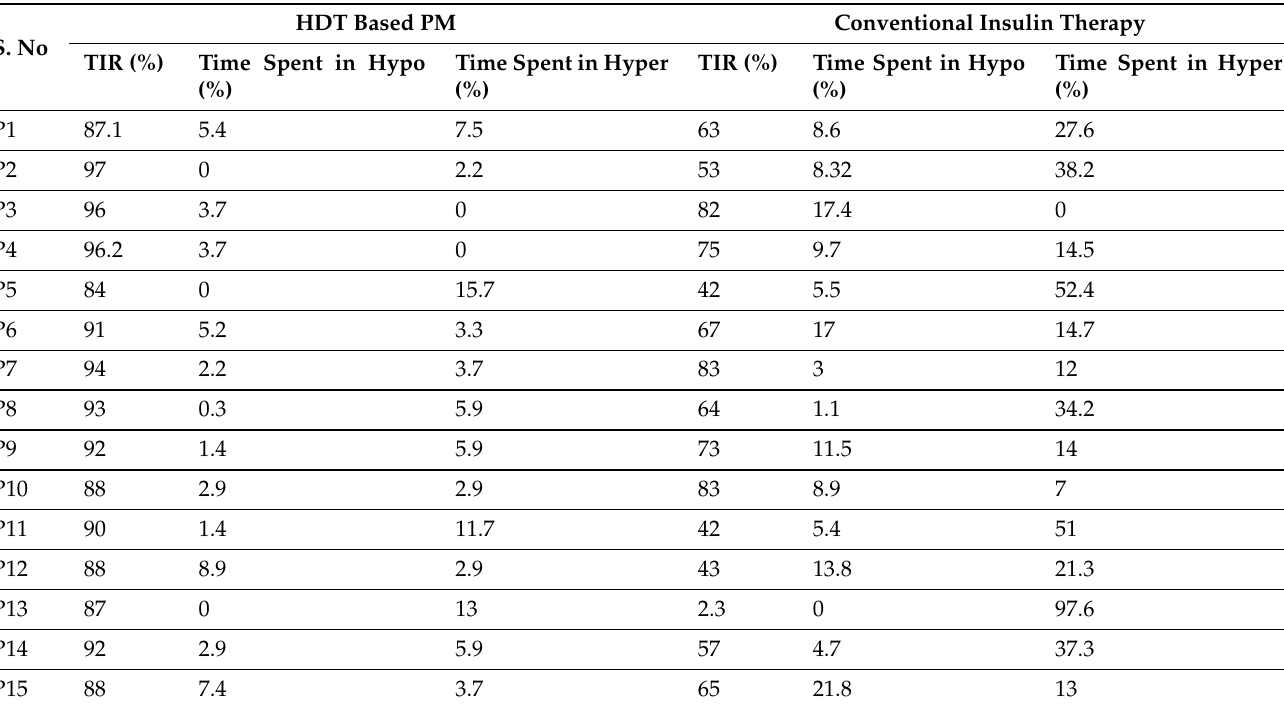
Table 5. Performance metrics for personalized AP.